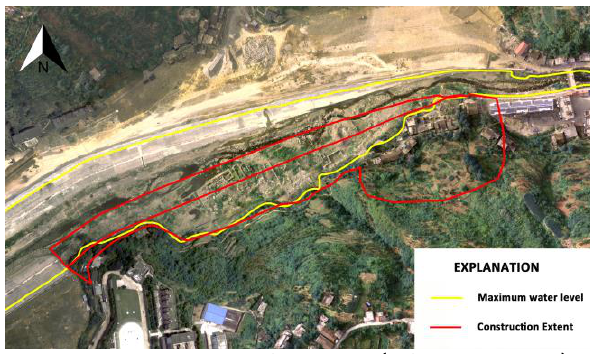
Figure 8. current DOM of study area